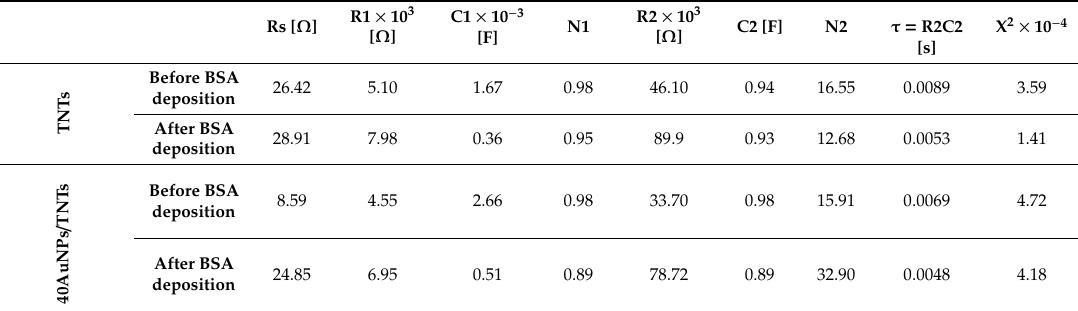
Table 5. Values of circuit equivalent elements for TNTs and 40AuNPs / TNTs before and after BSA